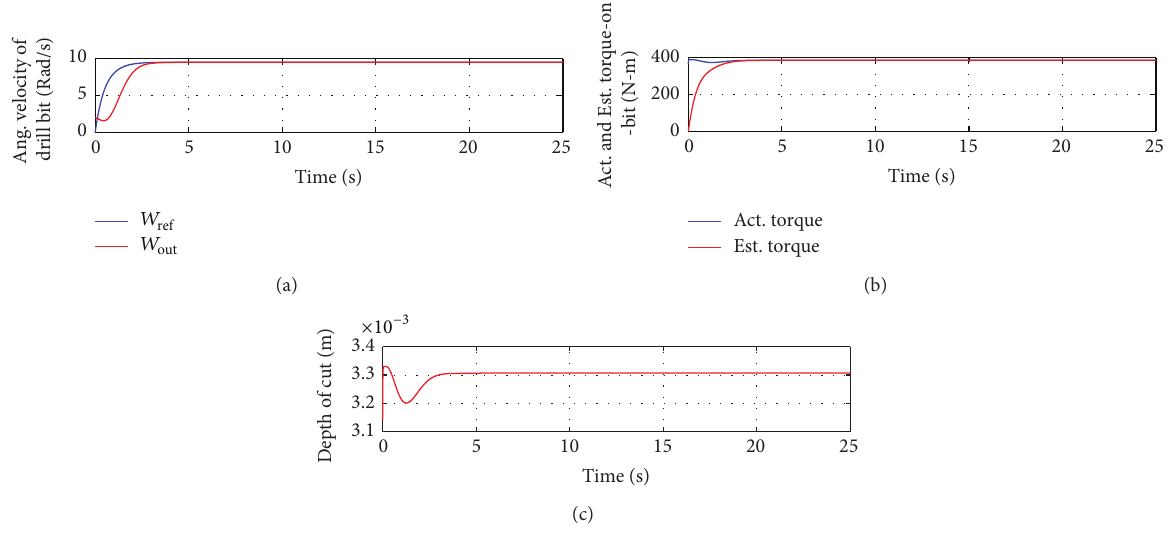
Figure 6: Response of rotational velocity 𝜔 1 (𝑡) (a), torque-on-bit 𝑇(𝑡) vresus estimated torque-on-bit for 𝑊 0 = 5000 N, 𝜖 = 20 MPa, and 𝛾 0 = 5 ⋅ 10 9